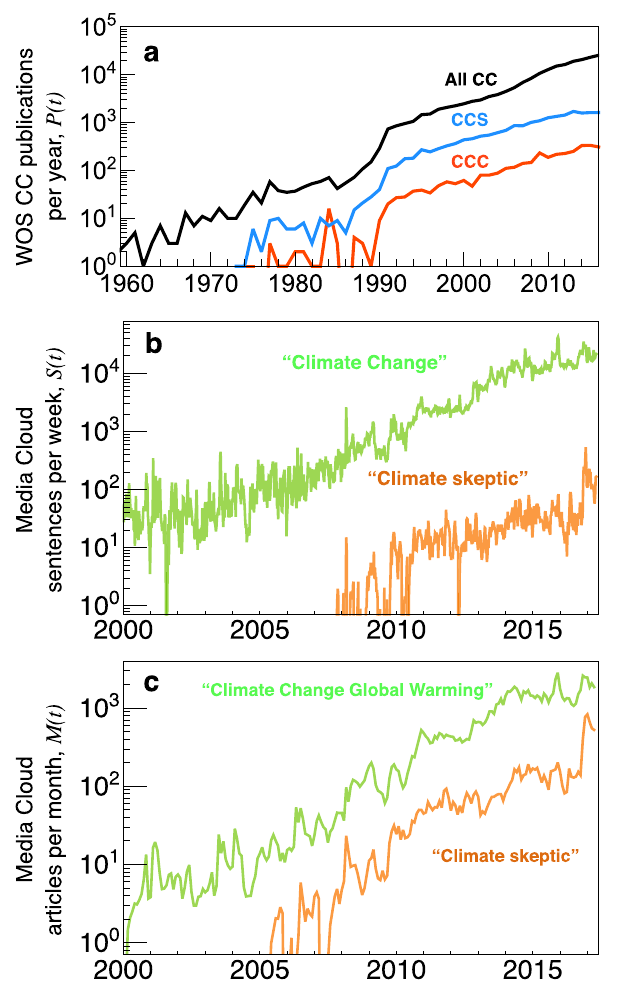
Fig. 1 Growth of research output and media production relating to climate change (CC). a Number P ( t ) of CC publication indexed by Web of Science by year t , with 93% published after 2000. The approximate linearity on linear-log axes indicates exponential growth with notable upticks in the late 1980s and late 2000s. b The prominence of three CC-related terms, measured by the number of sentences (per week) across all media articles indexed by Media Cloud. ( c ) Total number of media articles indexed by Media Cloud (per month, across all media sources). Exponential smoothing is used in b and c to tame the noise at the week and month